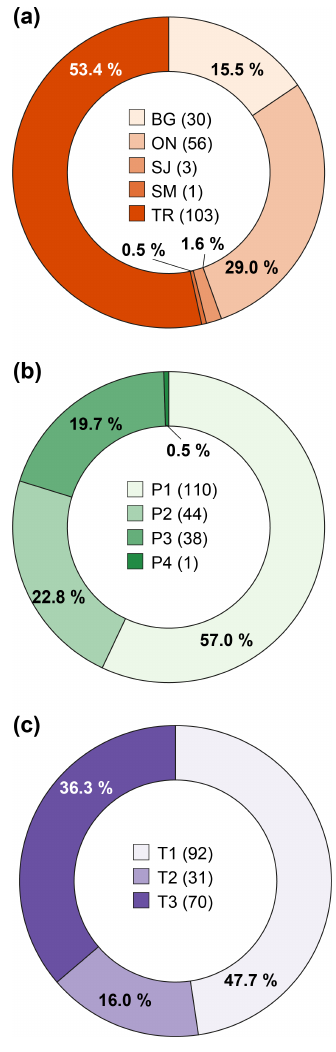
Figure 3. Donut charts with statistics of the landslide cat- alogue. (a) Number and percentage of landslide information source; key: ON, online newspapers and magazines; BG, blogs; TR, technical reports; SJ, scientific journals; SM, social me- dia; (b) number and percentage of landslides with decreasing mapping accuracy; key: P1 < 1km 2 (high), 1km 2 ≤ P2 < 10km 2 (medium), 10km 2 ≤ P3 < 100km 2 (low), 100km 2 ≤ P4 < 300km 2 (very low); (c) number and percentage of landslides with decreasing temporal accuracy; key: T1, hour of occurrence known; T2, part of the day known; T3, only day of occurrence